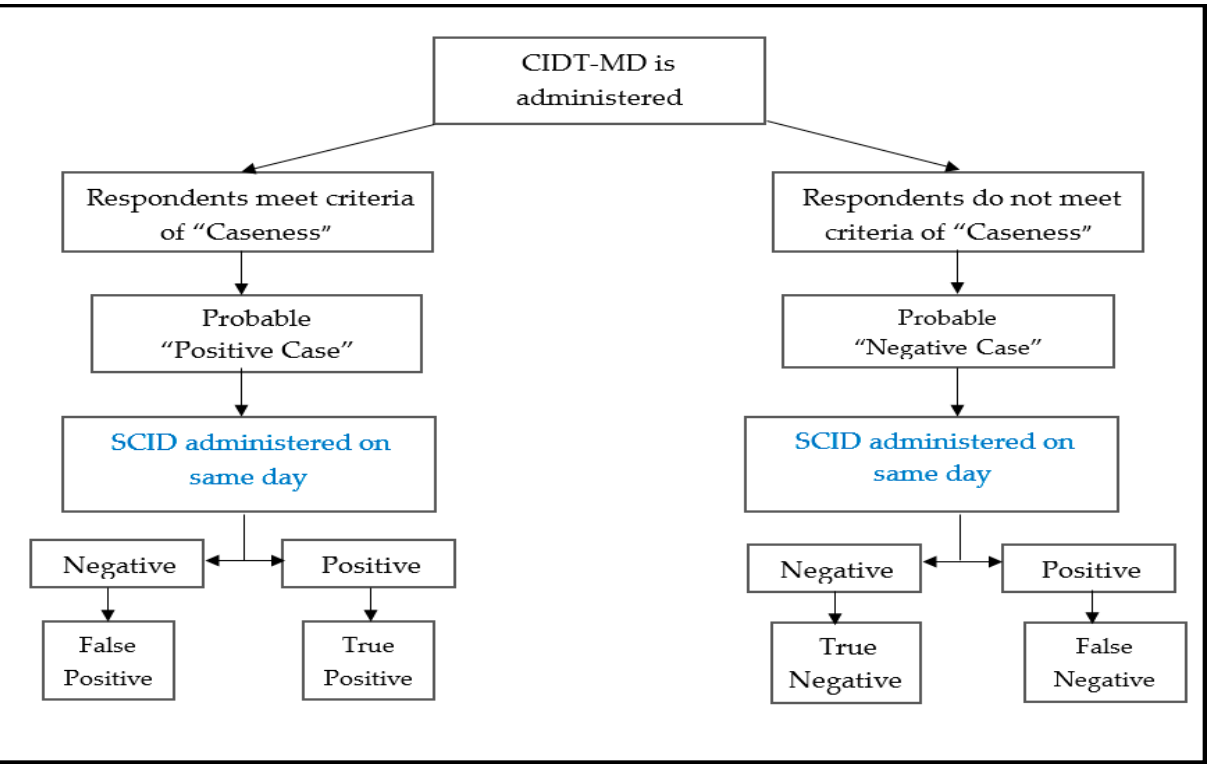
Figure 2. The Schematic Illustration of Assigning Caseness. (SCID is Structured Clinical Interviews of DSM Disorders).